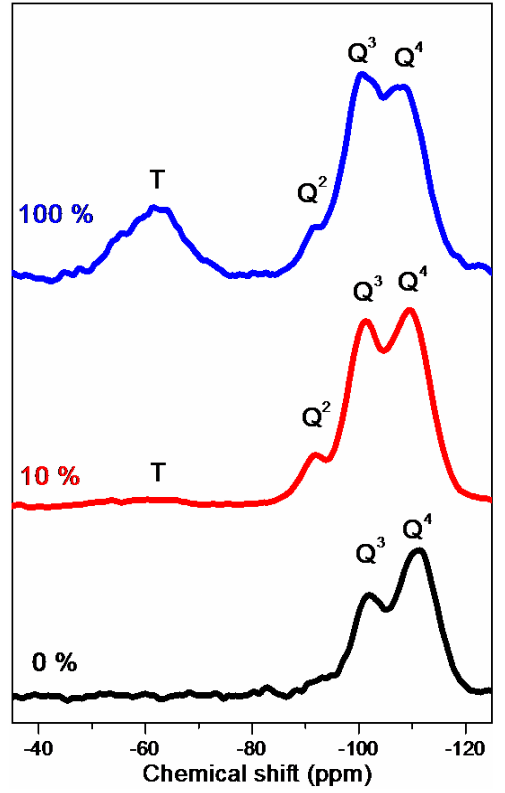
Figure 7. 29 Si CP/MAS solid state NMR spectra of mesoporous silica samples